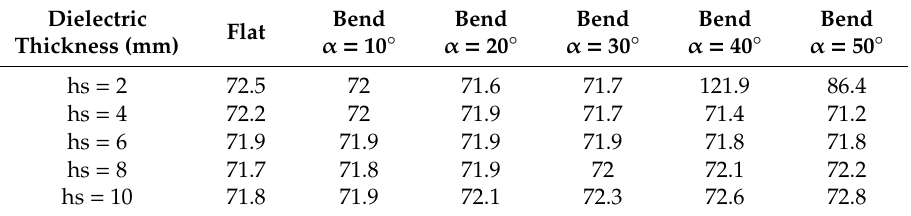
Table 4. Simulated antenna radiation pattern beam width ( ◦ ) for flat and bend positions at 2.45 GHz.